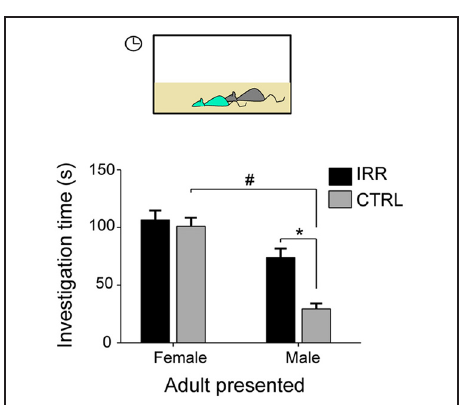
FIGURE 5 | Social interaction is altered in IRR females. Control females showed differential interaction with male and female conspecifics (#). However, IRR females behaved similarly toward both genders: interaction with male subjects resembled that observed with female subjects. Investigation time is shown as mean across experimental females. ∗ Significant difference between CTRL and IRR for the interaction with males. # Significant difference for CTRL females for the interaction with adult males and females. Modified from Feierstein et al.